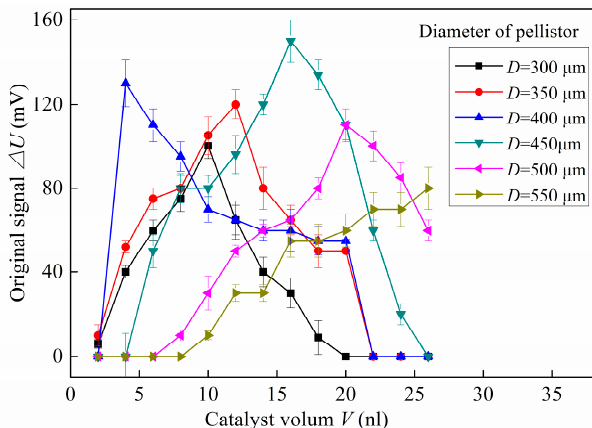
Figure 10. Variations in the original signals of the pellistor with porous matrix based on pellistor size and the amount of platinum palladium (Pd-Pt)